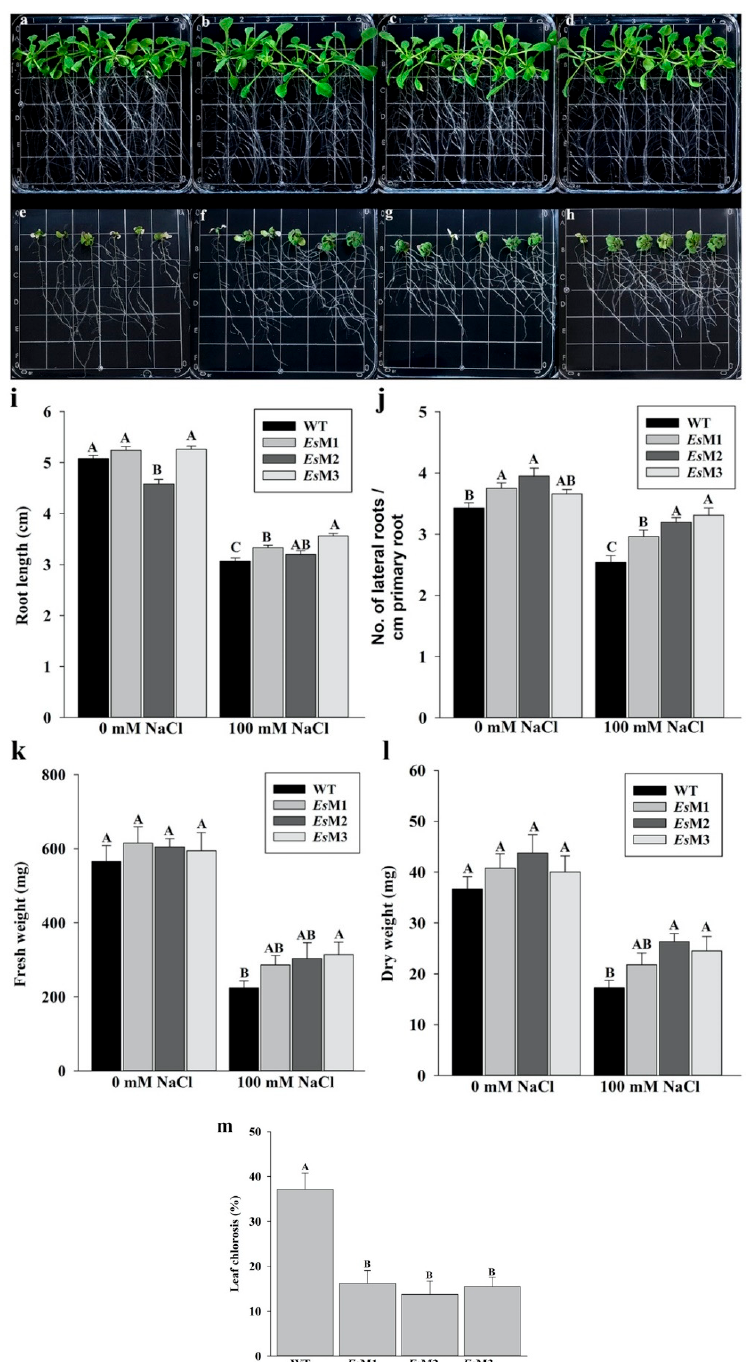
Figure 1. Seedlings growth, root length, number of lateral roots per cm of primary root, fresh weight (FW), dry weight (DW) and leaf chlorosis of the wild type and 3 independent transgenic lines ( Es M1, Es M2 and Es M3), in the absence and presence of 100 mM NaCl. ( a – d ), seedlings were grown under standard conditions or ( e – h ), seedlings were grown in the presence of 100 mM NaCl. ( a , e ) WT, ( b , f ) Es M1, ( c , g ) Es M2 and ( d , h ) Es M3. The seedlings were photographed at 11 days after transfer in standard and under salinity stress conditions. Each grid has 13 mm. ( i ) root length, ( j ) number of lateral roots per cm of primary root, ( k ) fresh weight, ( l ) dry weight and ( m ) leaf chlorosis. Columns represents the mean and the bars the standard error; n = 150 for root length, number of lateral roots per cm of primary root and leaf chlorosis and n = 18 for fresh weight and dry weight. Means and SE with the same letter are not significantly di ff